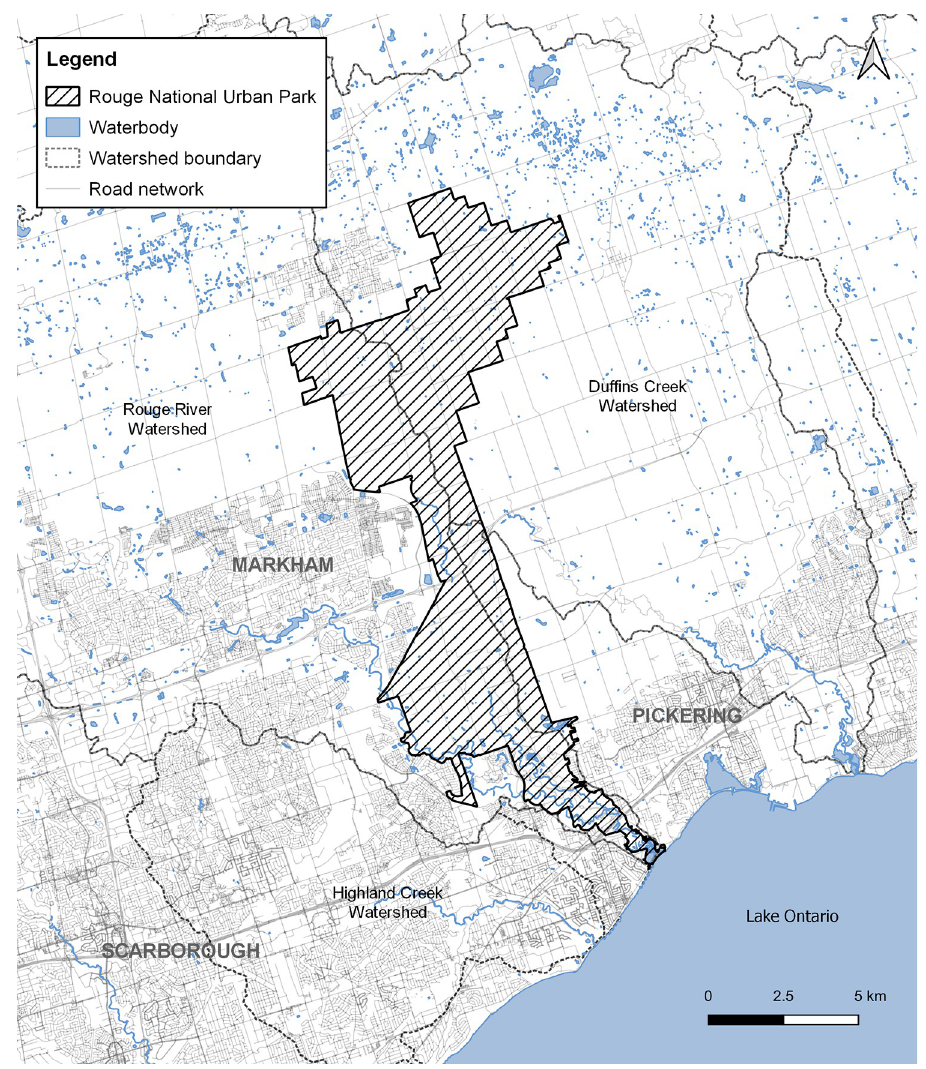
Fig 1. Spatial overview of the Rouge National Urban Park in Toronto, Ontario, Canada. The exact location of the study site is excluded to protect at-risk species from poaching. The map was created by compiling data available from https://geohub.lio.gov.on.ca/ on QGIS (3.20.1-Odense) [29–32].